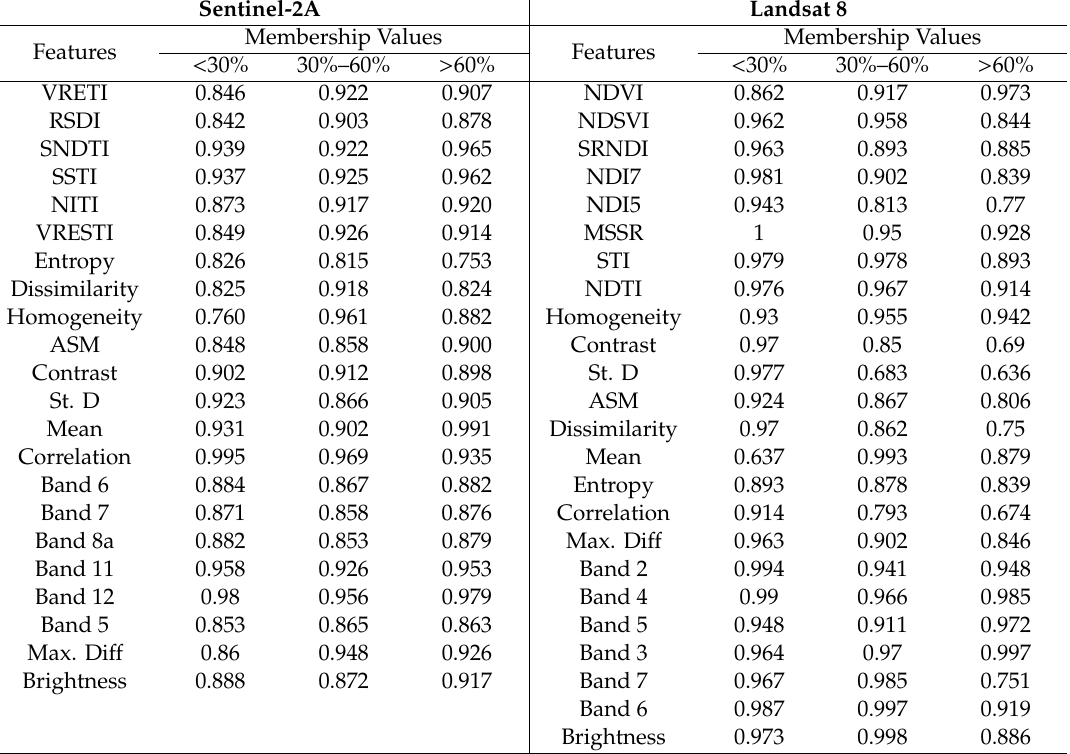
Table 5. Membership values of feature spaces for the Sentinel-2A and Landsat-8 images.